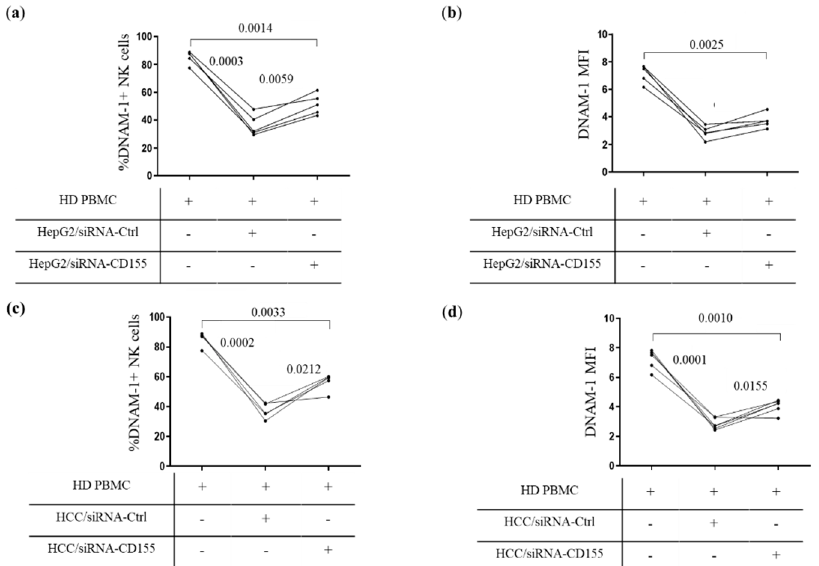
Figure 4. Tumor-siRNA-CD155 transfected cells modulate DNAM-1 expression. ( a ) Frequency of DNAM-1+ NK cells and ( b ) DNAM-1 expression (MFI) in PBMCs from 5 HDs exposed to siRNA- CD155- or siRNA-control-transfected HepG2 cells. ( c ) Frequency of DNAM-1 positive NK cells and ( d ) MFI were evaluated in NK cells of PBMCs from five HDs after exposure to primary HCC cells transfected with siRNA-CD155 or siRNA-control. Matched data were analyzed by a parametric ANOVA